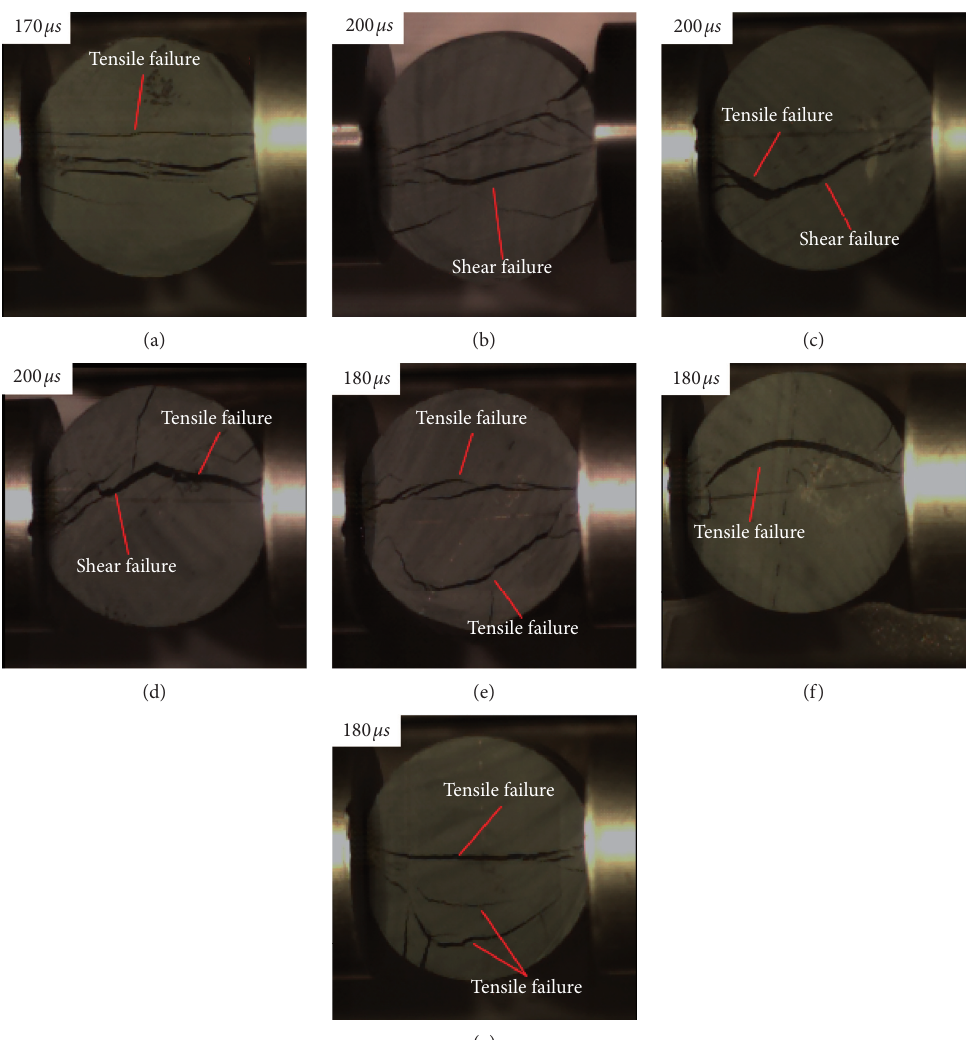
Figure 12: The failure process of the rock disc for the seven tested layer inclination angles by HSC. (a–g) The inclination angles of 0 ° , 15 ° , 30 ° , 45 ° , 60 ° , 75 ° , and 90 ° , respectively. (a) β � 0 ° . (b) β � 15 ° . (c) β � 30 ° . (d) β � 45 ° . (e) β � 60 ° . (f) β � 75 ° . (g) β � 90 ° .